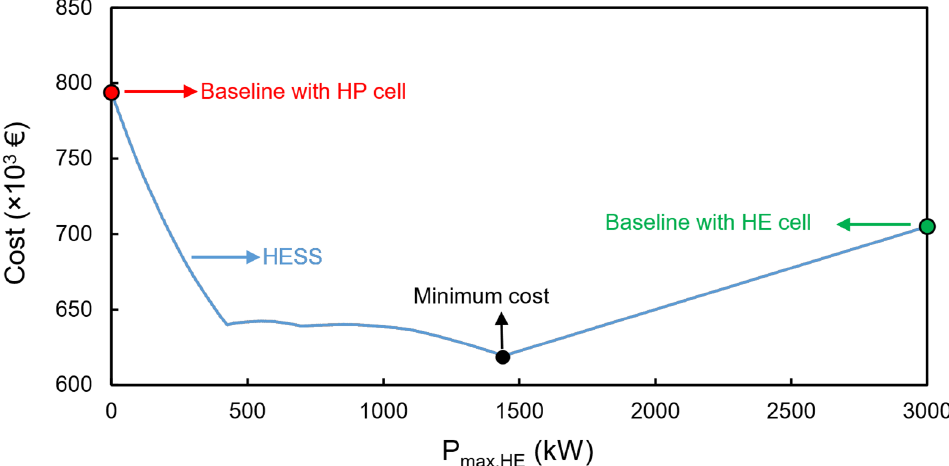
Figure 8. Cost of the HESS and monotype battery systems versus 𝑃 (cid:3040)(cid:3028)(cid:3051) , (cid:3009)(cid:3006) .